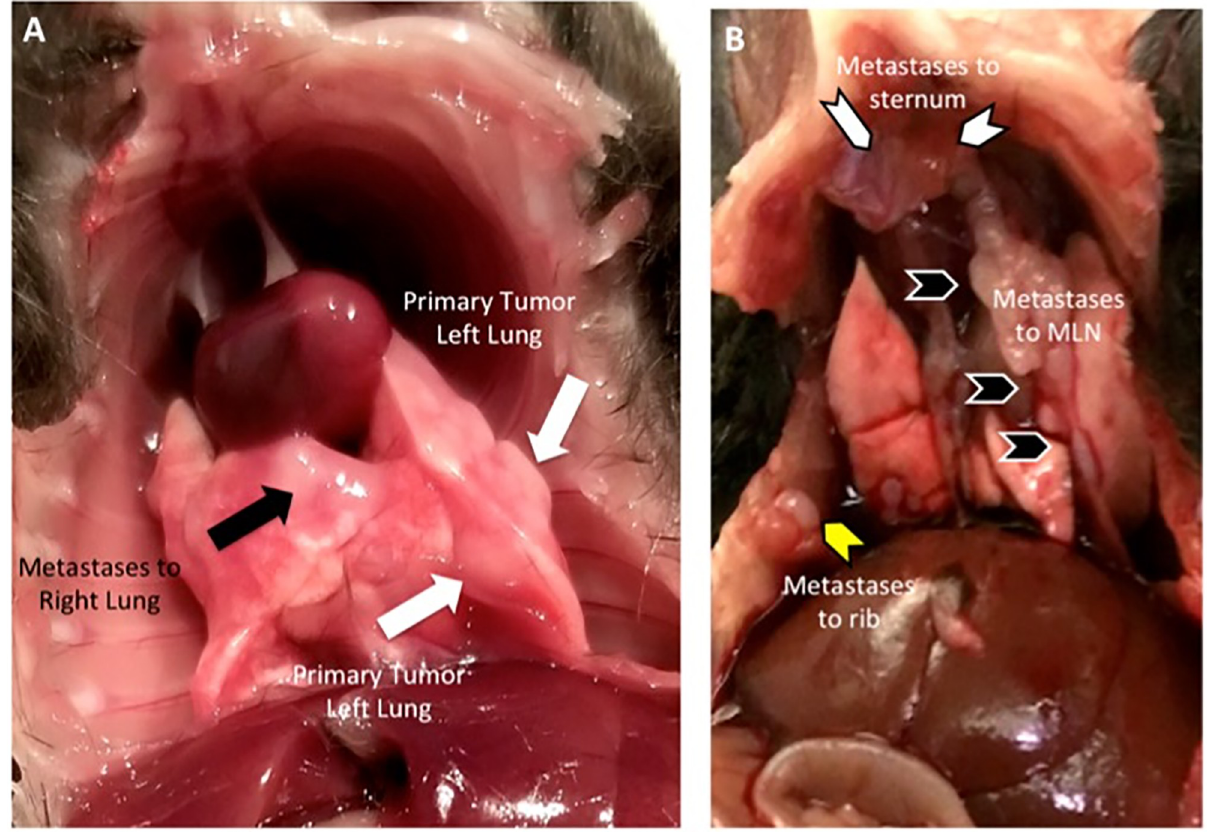
Fig 6. Metastases visualized at harvest. (A) Metastases to right lung (black arrows) is visualized at harvest in addition to primary tumor (white arrows) in the left lung (site of Ad5CMVCre virus injection). (B) Metastases to mediastinal lymph nodes (black chevron), rib (yellow chevron) and sternum (white chevron) is visualized at